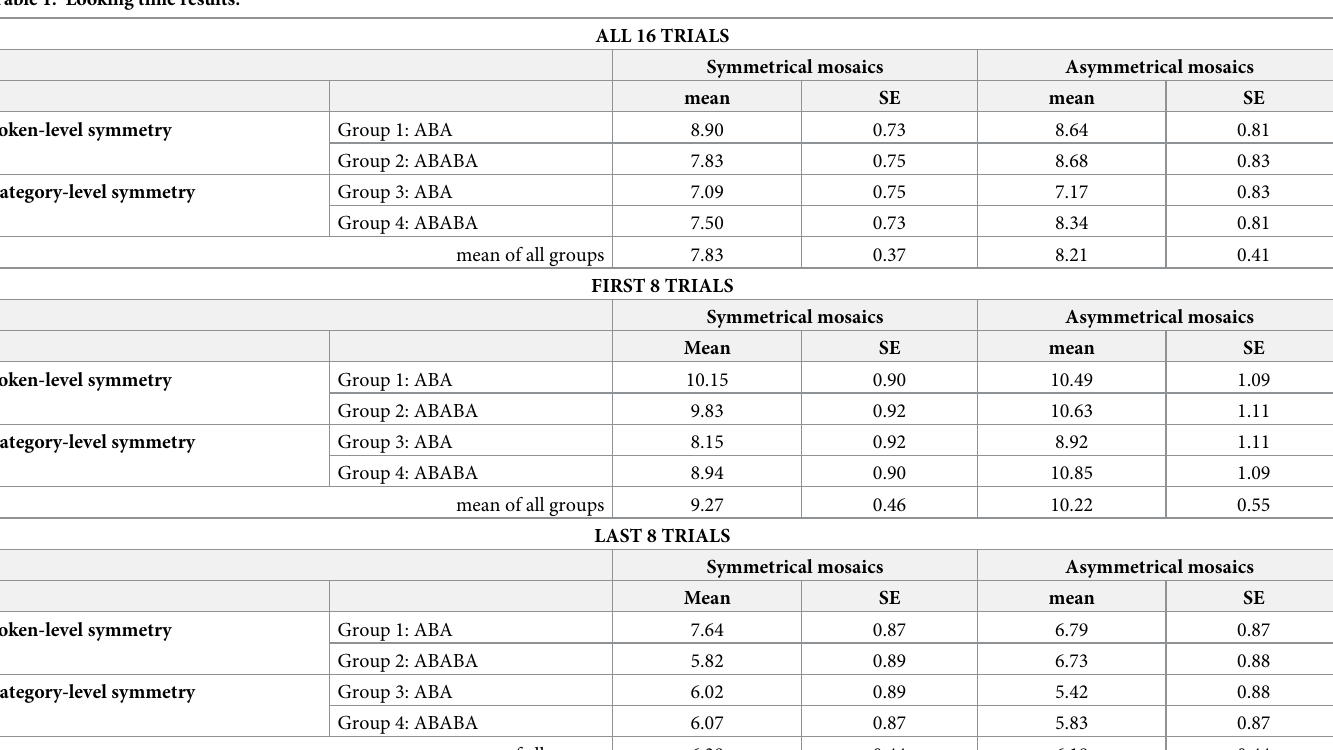
Table 1. Looking time results.